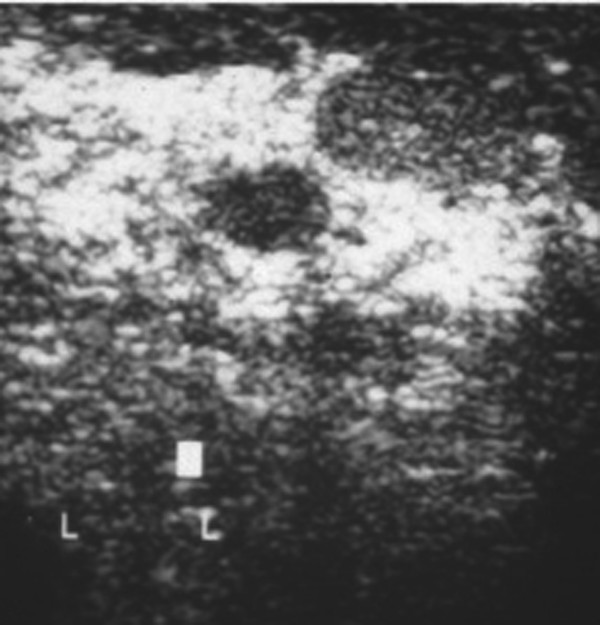
Ultrasound of the MRI-detected lesion. Following MRI, the patient was scheduled for ultrasound to identify the questionable lesions seen on MRI for possible core biopsy. Under ultrasound the lesion of concern was identified and biopsied at the 1:00 location in the left breast. Additionally, one lesion seen by MRI in the right breast at the 4:00 location was identified and biopsied.